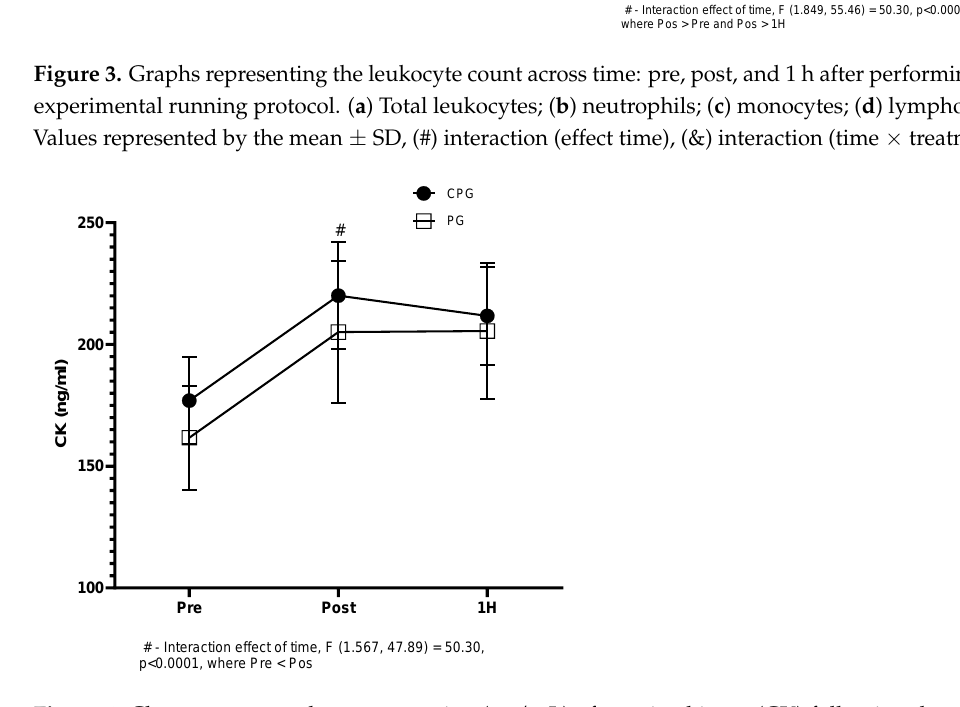
Figure 4. Chart represents the concentration (ng/mL) of creatine kinase (CK) following the experi- mental running protocol. Values represented by the mean ± SD, (#) interaction (effect of time).